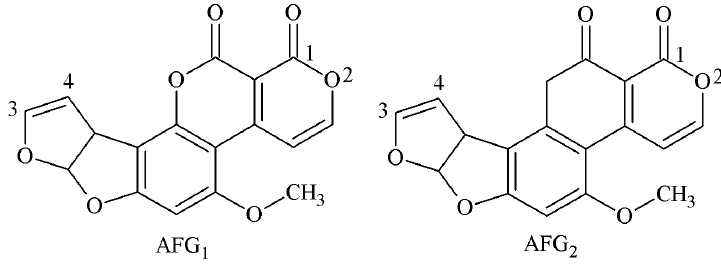
Figure 8. Molecular structure of AFG1 and AFG2.